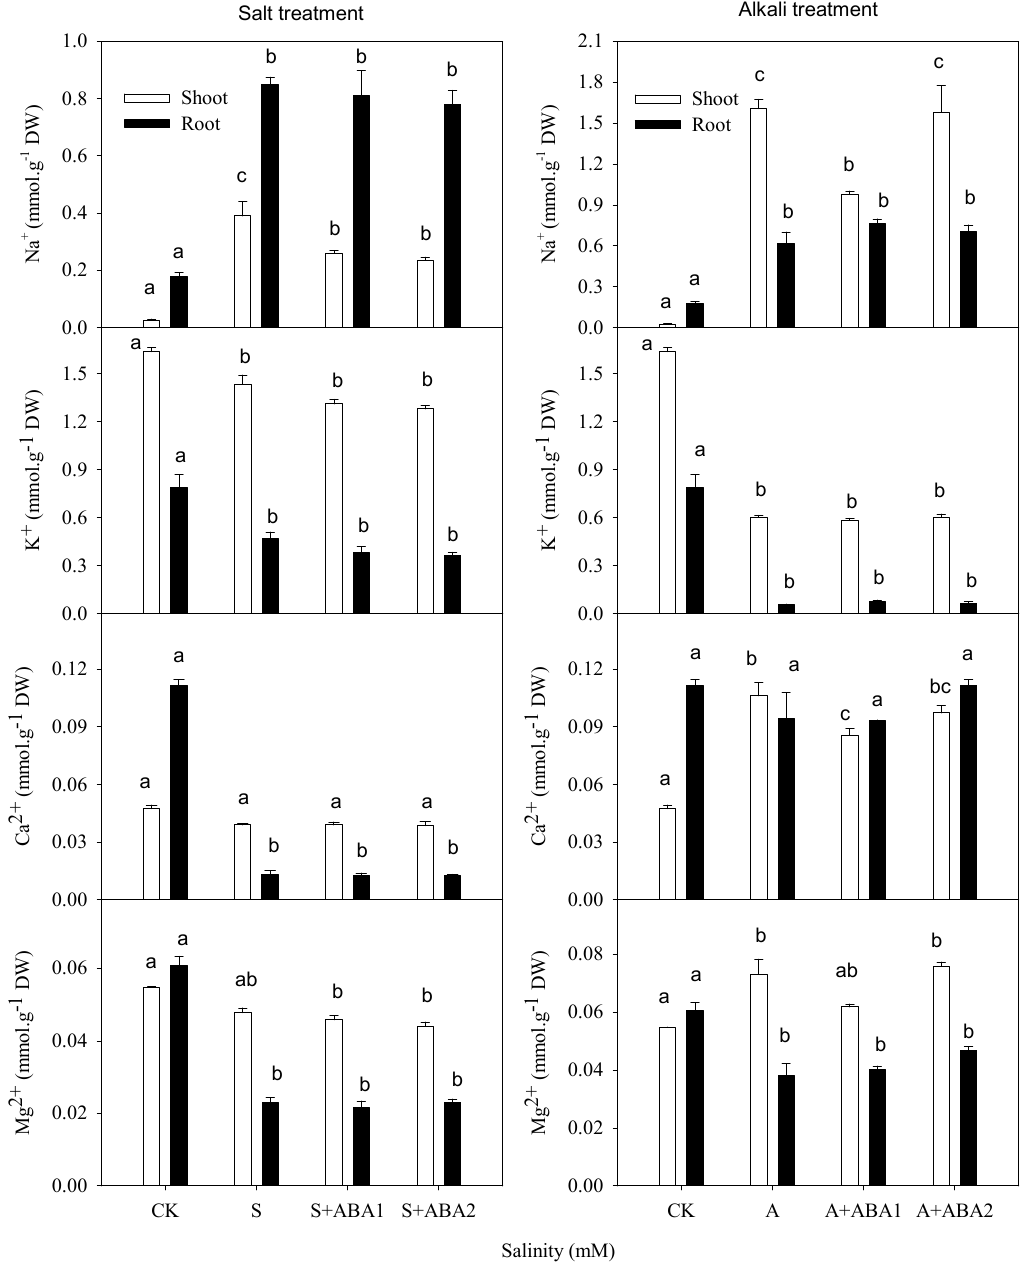
Figure 1. Effect of salt and alkali stress, with or without ABA treatment on the concentration of the main cations in shoots and roots. Means with different letters in columns with different colors are significantly different ( p < 0.05). DW: dry weight; CK: control, nutrient solution alone; S: 100 mM mixed neutral salts (NaCl:Na 2 SO 4 = 9:1) added to nutrient solution; A: 100 mM mixed alkaline salts (NaHCO 3 :Na 2 CO 3 = 9:1) added to nutrient solution; ABA1: 50 µ mol ABA; ABA2: 100 µ mol ABA. Below was the same.